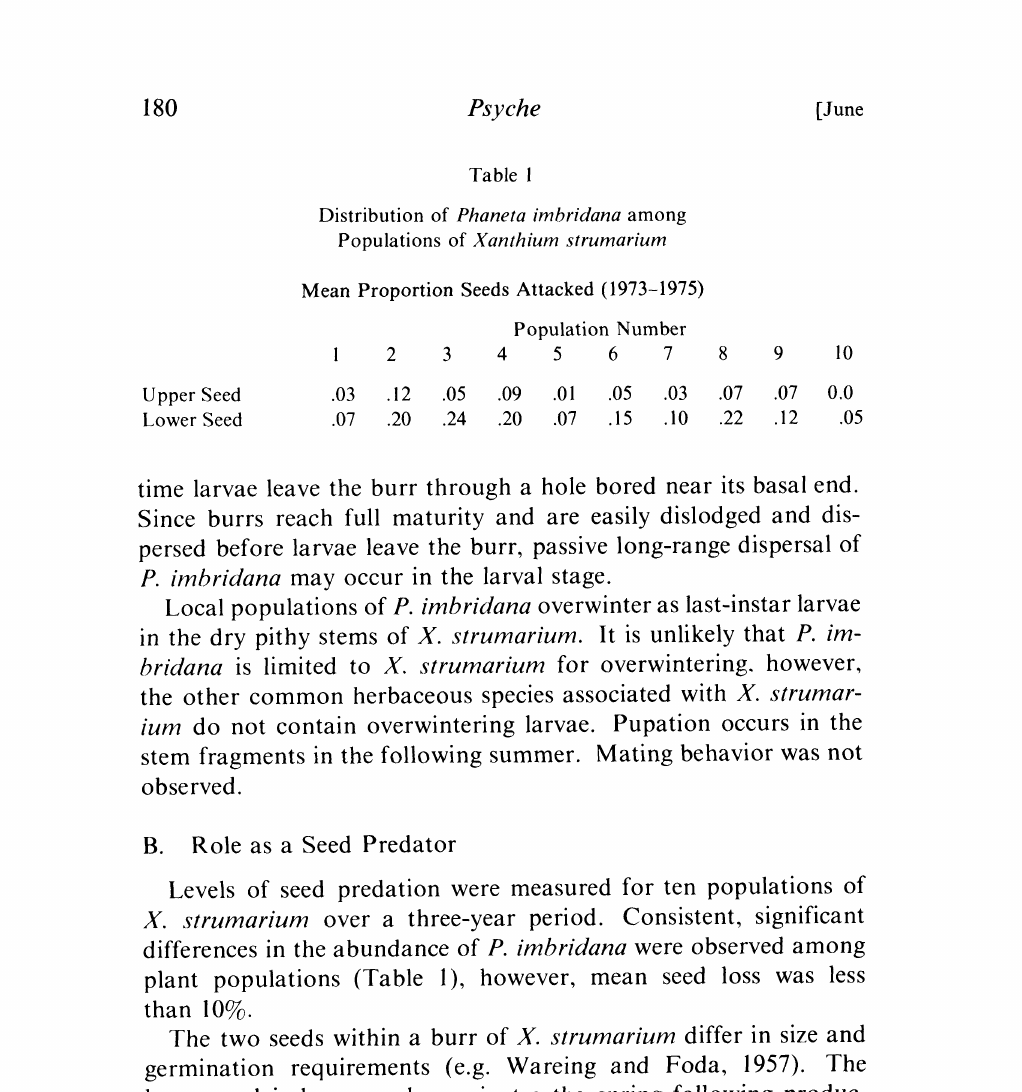
Distribution of Phaneta imbridana among Populations of Xanthiurn strumariurn Mean Proportion Seeds Attacked